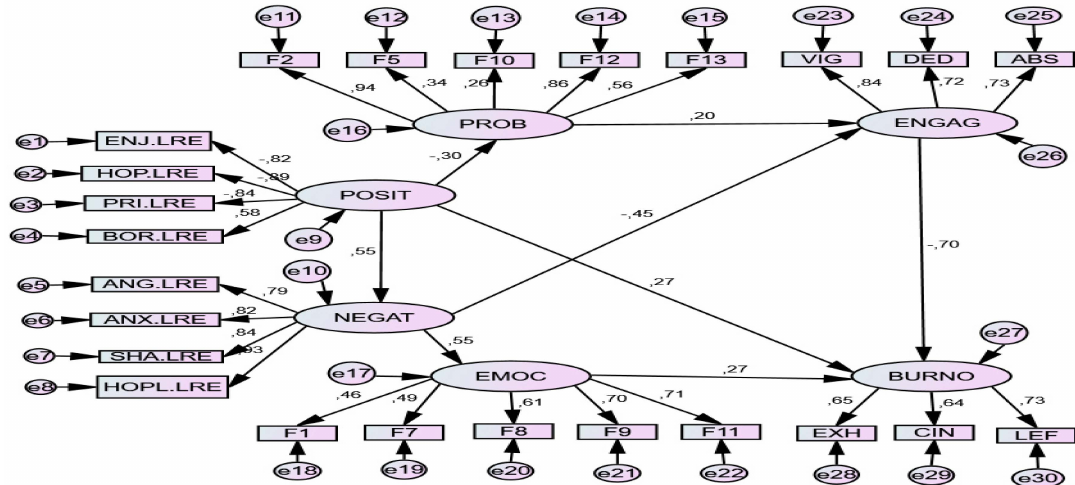
Figure 3. SEM model for Study Situation (Stress level 2) . Note . POSIT = Positive Achievement